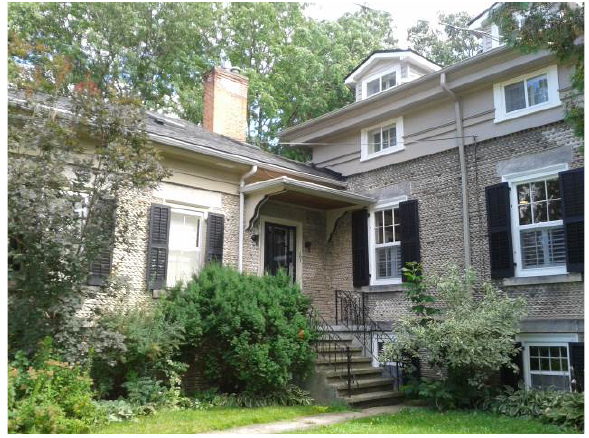
Figure 12. Cobblestone construction, Hamilton Place in Paris, Ontario, Canada (Source: author).